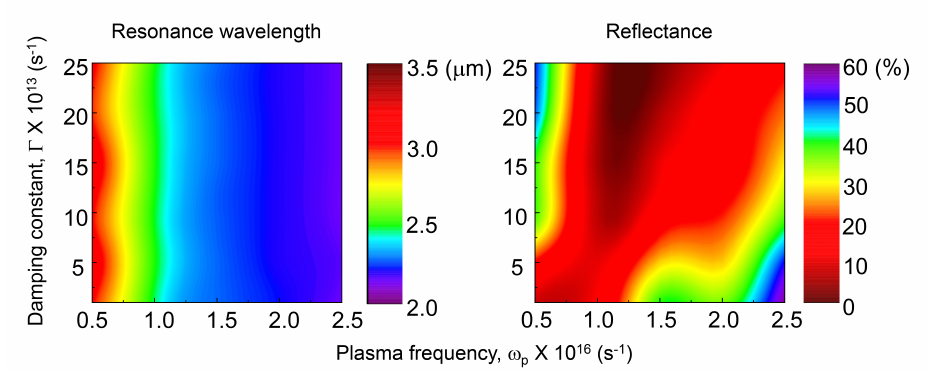
Figure 5. FDTD simulations with artificial Drude parameters that have ω p from 0.5 to 2.5 × 10 16 s − 1 , Γ from 1 to 5 × 10 13 s − 1 and ε ∞ = − 20.8